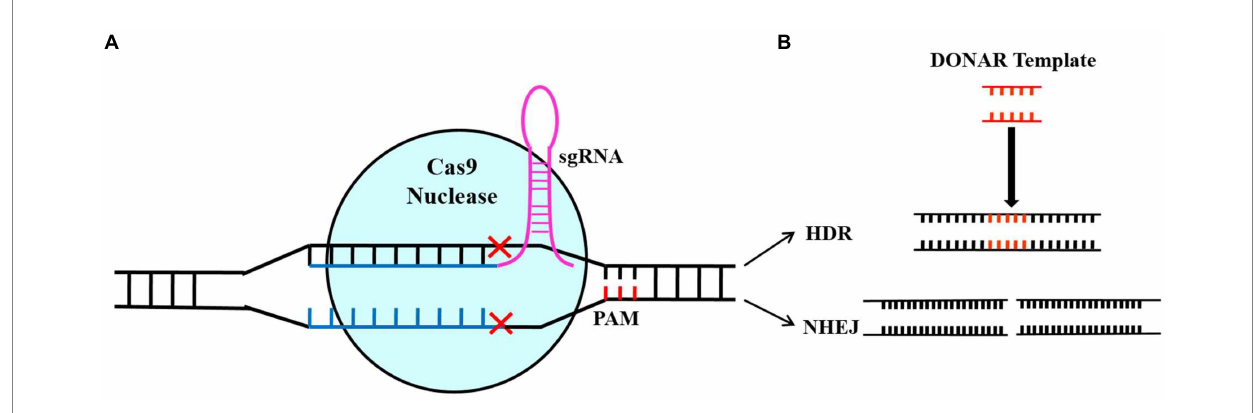
FIGURE 1 Illustration of Cas9/sgRNA-based genome editing. The diagram showing the sgRNA-mediated Cas9 protein binding to the target sequence and knocking out the double strand of DNA (A) and the self-repair mechanism of the cell after DNA double-strand breakage (B) . A non-homologous end- joining repair pathway results in random loss, introduction, and replacement of bases at damaged points, thus resulting in gene mutation. By using the homology repair pathway (HR), the gene of interest will be precisely edited based on fragments of donor DNA (Song et al.,